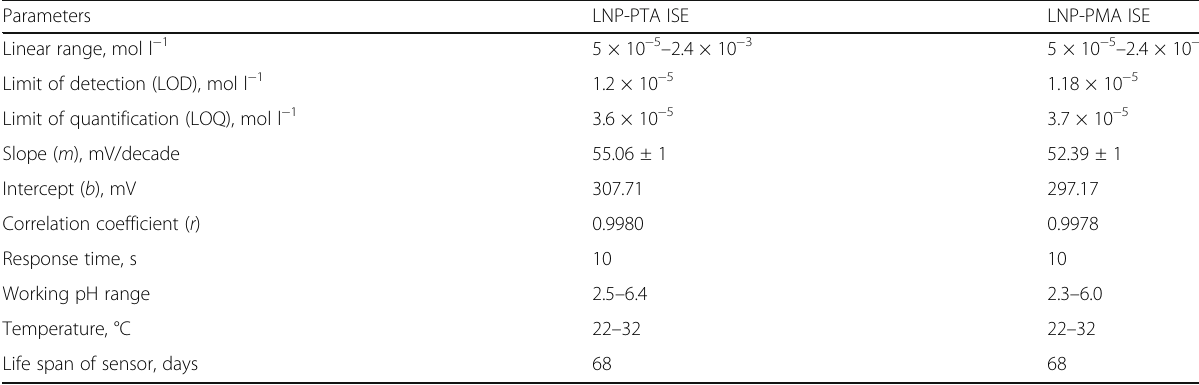
Table 3 Performance characteristics of LNP ISEs Parameters LNP-PTA ISE LNP-PMA ISE Linear range, mol l −